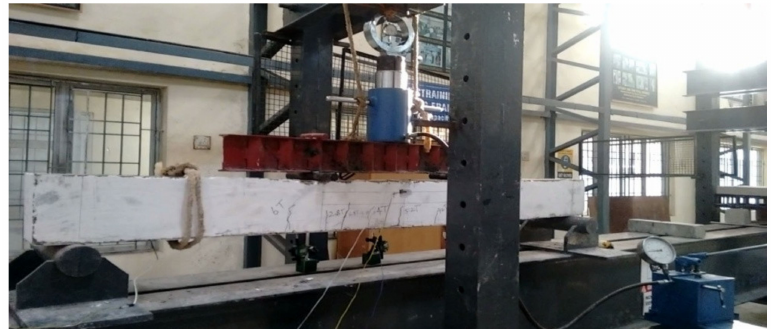
Figure 12. SCS beam with shear studs under flexural test (before testing).